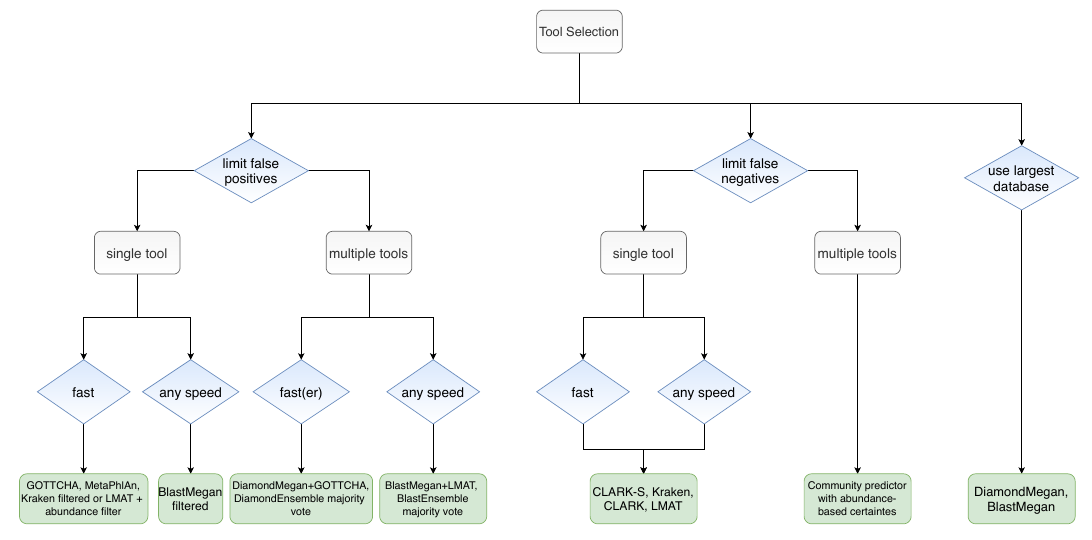
Figure 13. Algorithm for tool